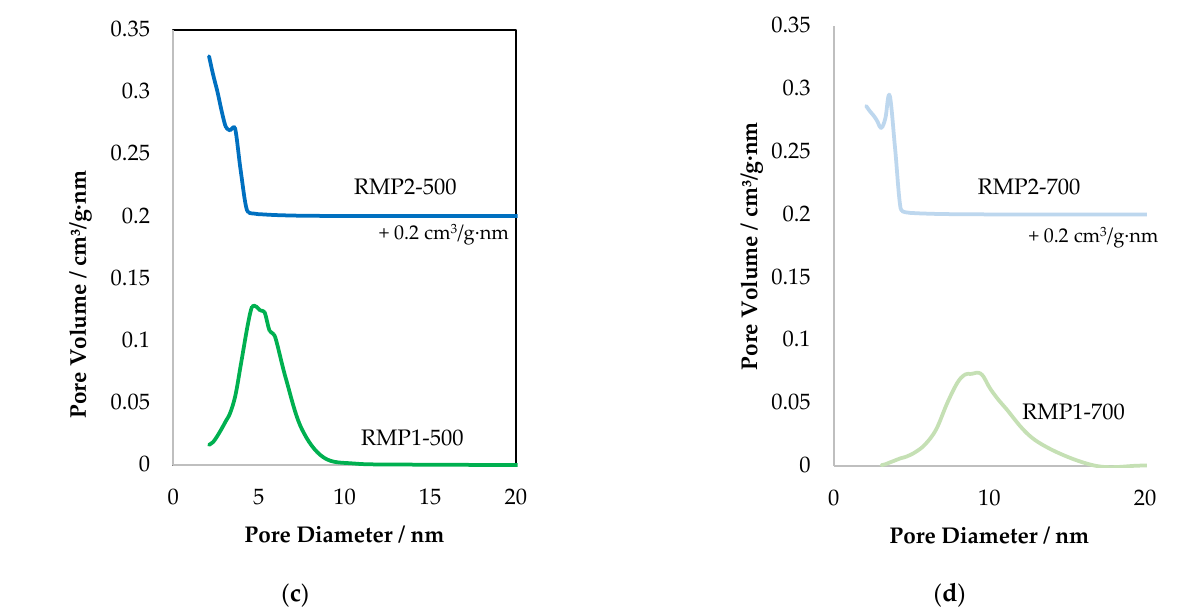
Figure 7. ( a , b ) N 2 adsorption – desorption isotherms and ( c , d ) the corresponding pore size distribution curves of the RMP samples, shifted by 0.2 cm 3 /g·nm, for more clarity. Table 5. Textural properties of the RMP samples from N 2 physisorption analysis.